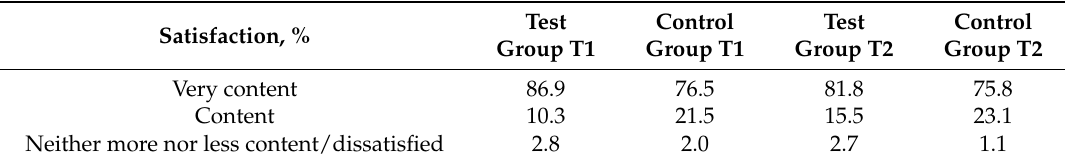
Table 7. Satisfaction with the housing situation in both groups T1 (three months after moving in) and T2 (one year